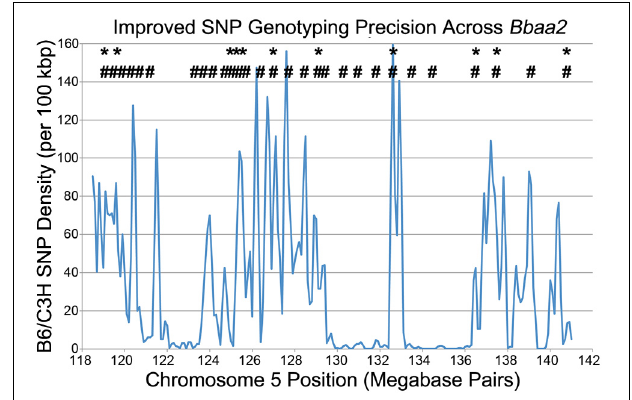
FIGURE 3 | A SNP genotyping methodology improves congenic mapping precision, adapted from Bramwell et al. (2012). ∗ - Location of all 11 microsatellite markers that can differentiate between B6 and C3H DNA across Bbaa2 . # - Of the thousands of SNPs available (blue line), the 28 positions that were developed into SNP genotyping assays for improved discrimination of sub-interval congenic lines (Bramwell et al., 2014).